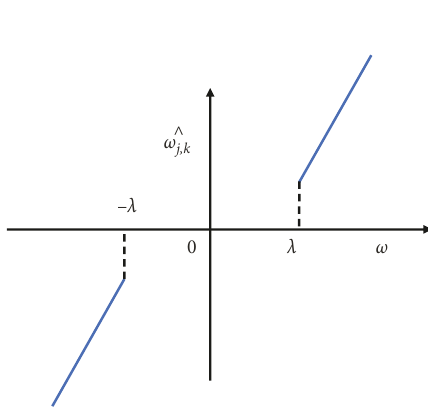
Figure 5: Hard threshold